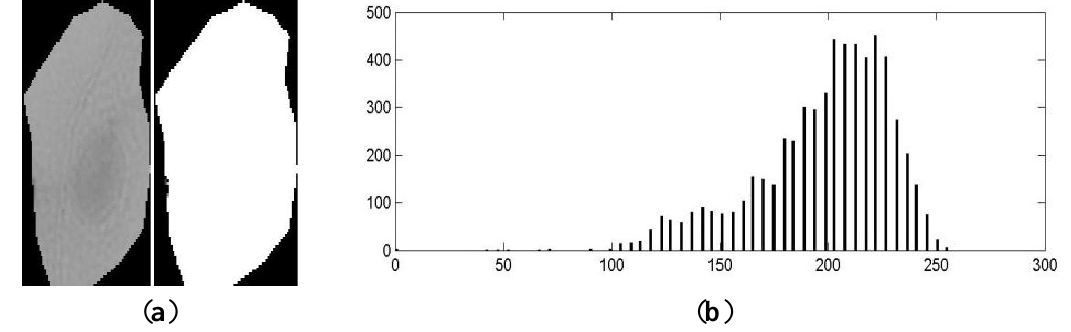
Figure 10. ( a ) An under-segmentation result produced by the mean shift using only the gray level information; ( b ) In this case, the gray level distribution of the cell pixels does not show distinctive peaks.